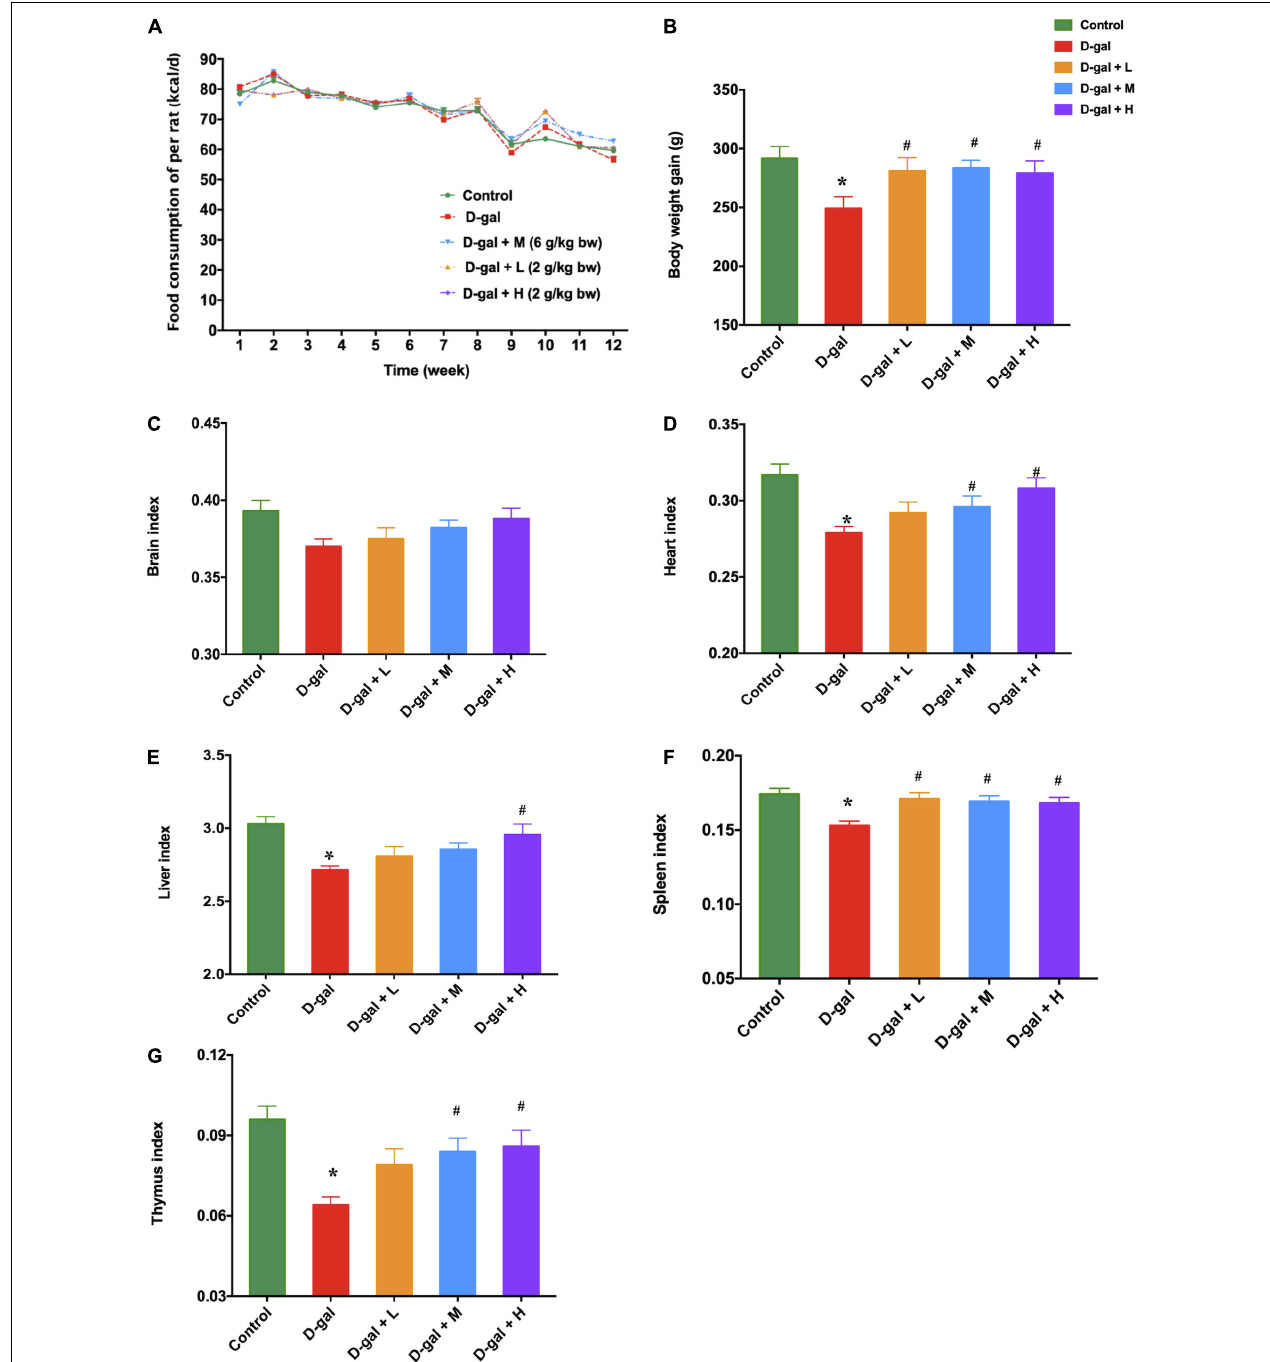
FIGURE 2 | Effects of the dietary supplement on mean energy of food consumption (A) , mean body weight gain (B) , and organ indices (C–G) in D-gal induced aged rats at the end of supplementation (week 13). The data are presented as mean ± SEM ( n = 12). * p < 0.05 when compared with the control group; # p < 0.05 when compared with the D-gal group. D-gal, D-galactose; SEM, standard error of mean.